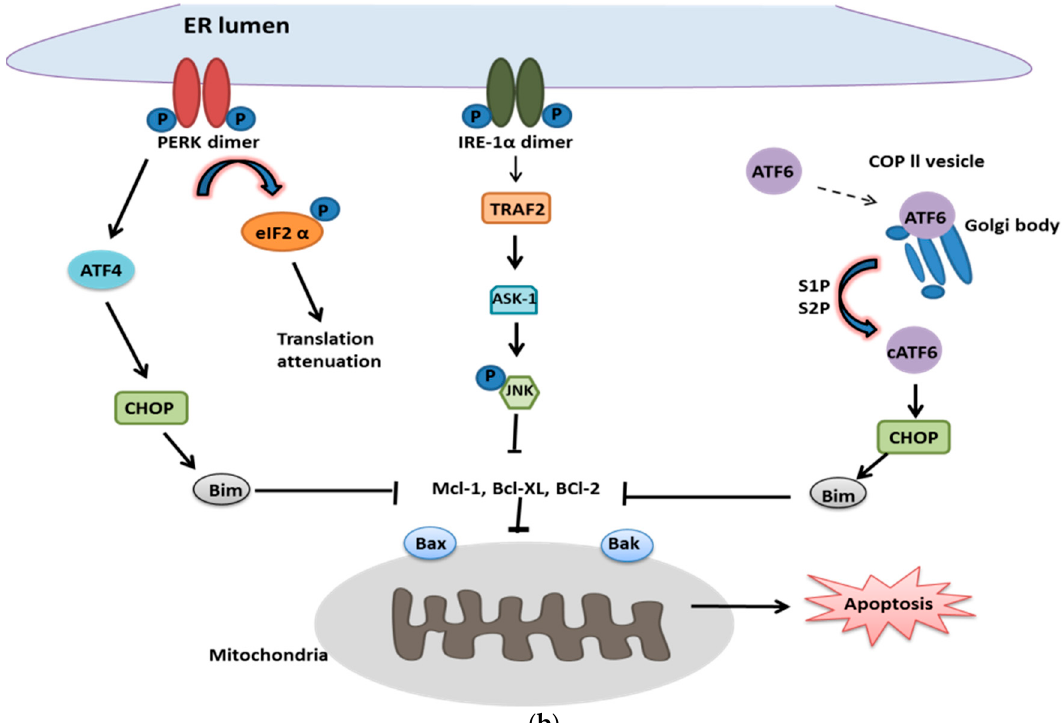
Figure 2. Unfolded protein response and cell survival or death. ( a ) PERK provides cancer cell survival. PERK can activate ATF4, which upregulates the genes with roles in antioxidant response for survival. Moreover, PERK can stimulate Nrf2 to inactivate cell death signaling, CHOP, and phosphorylated elF2 α to attenuate translation for survival. Another transmembrane protein of the UPR membrane, IRE-1, and ATF6 also have crucial roles in cancer cell survival. Under the moderate level of ER stress, activated IRE-1 removes the introns of inactivated XBP1 to form spliced XBP1 (XBP1s). XBP1s serves as a transcription factor and binds with the promoter of chaperone and ERAD genes for modifying or degrading misfolded proteins for cell survival. Besides, ATF6 translocates from the ER membrane to the Golgi body. After moving to the Golgi body, ATF6 is cleaved to release the transcription factor (active segment) that induces the expression of chaperones and ERAD [42]; ( b ) When cells are overloaded with misfolded proteins, three transmembrane proteins of UPR are inclined to trigger cell death signals. Activated PERK phosphorylates elF2 to block protein synthesis. Furthermore, inactive elF2 will induce ATF4, a transcription factor that promotes Noxa and CHOP (both are pro-apoptotic transcription factors). Then, CHOP stimulates Bim, a pro-apoptotic protein of Bcl-2 families, and directly activates Bax and Bak on the membrane of mitochondria to trigger apoptosis. Furthermore, once IRE-1 is phosphorylated by extensive UPR, it will recruit TRAF 2 and activate apoptosis signal-regulating kinase 1 (ASK1) to phosphorylate JNK. Activated JNK can inhibit anti-apoptotic proteins, such as Mcl-1 and Bcl-XL, to trigger cell death signaling. Another pathway, cleaved ATF6, also induces CHOP expression and leads to apoptosis.